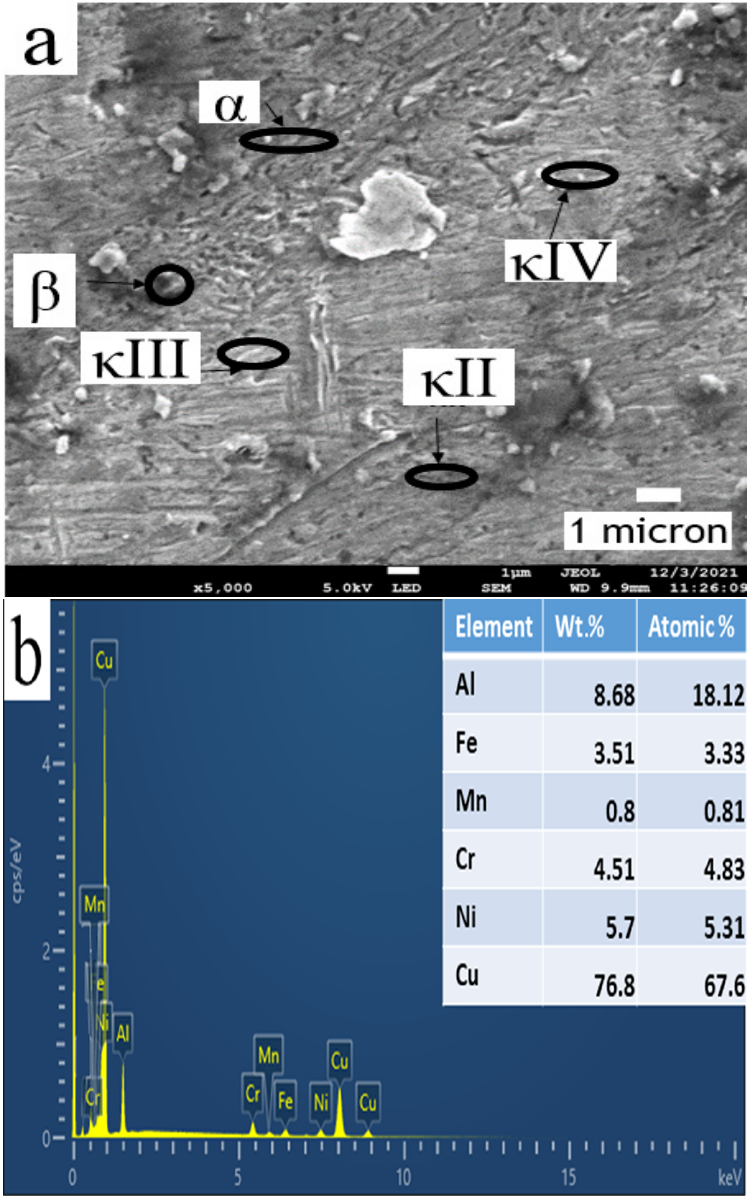
Figure 8. ( a ) FE-SEM image of the FSPed NAB–Cr composite and ( b ) EDS image of the FSPed NAB–Cr composite.